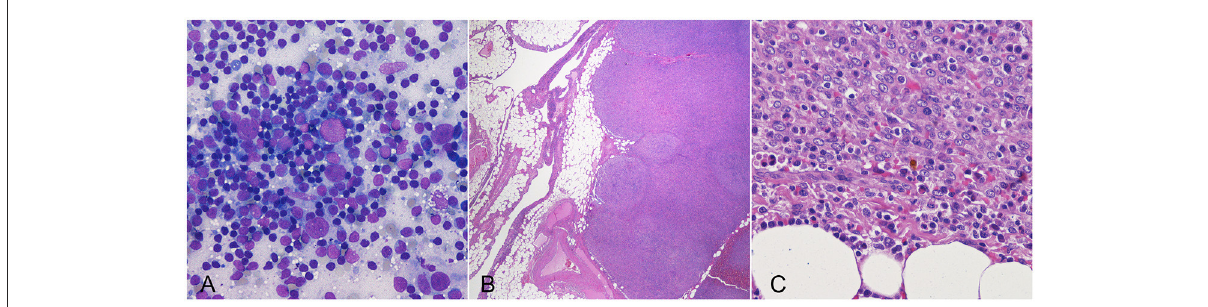
FIGURE2 Dog, cytologic (A) and histologic (B,C) preparations of hepatic (A) and omental (B,C) metastasis from a splenic tumor. Lesions are composed by a pleocellular infiltrate of atypical stromal cells, histiocytes and lymphocytes, similar to the primary